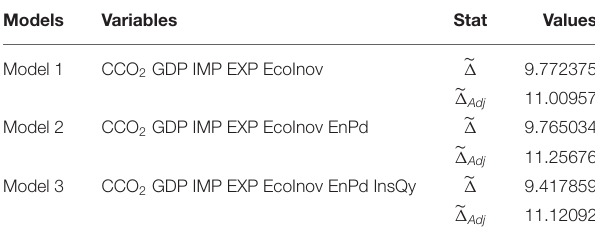
TABLE 3 | Slope heterogeneity test.